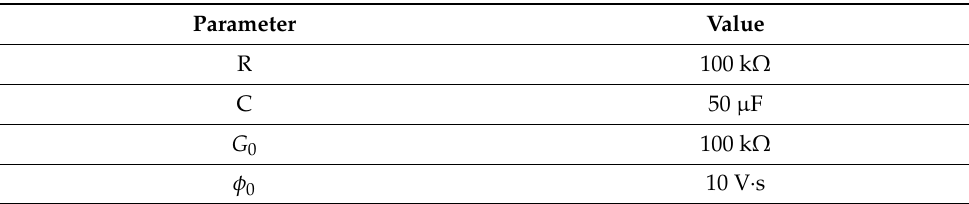
Table 1. Parameter values for the elements of the circuit in Figure 3, where the memristor is defined by Equation (1).